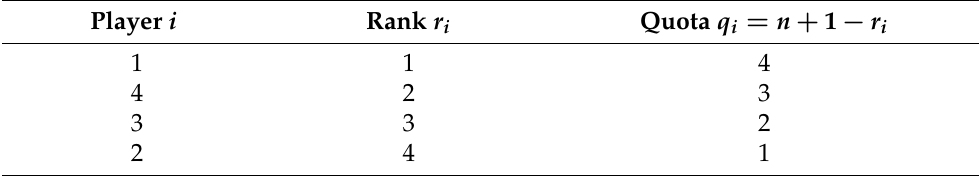
Table 1. Players’ ranking and quotation for n =